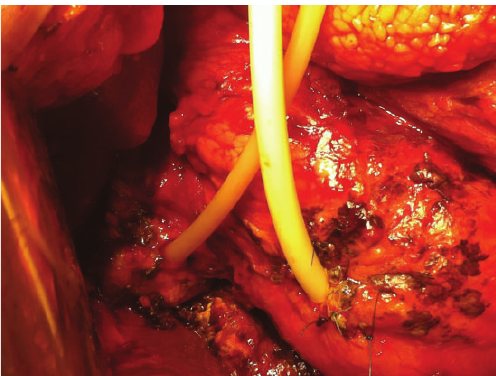
Figure 2: During relaparotomy, the ruptured ultralow duodenal stump was managed by tube duodenostomy and cholangiostomy.